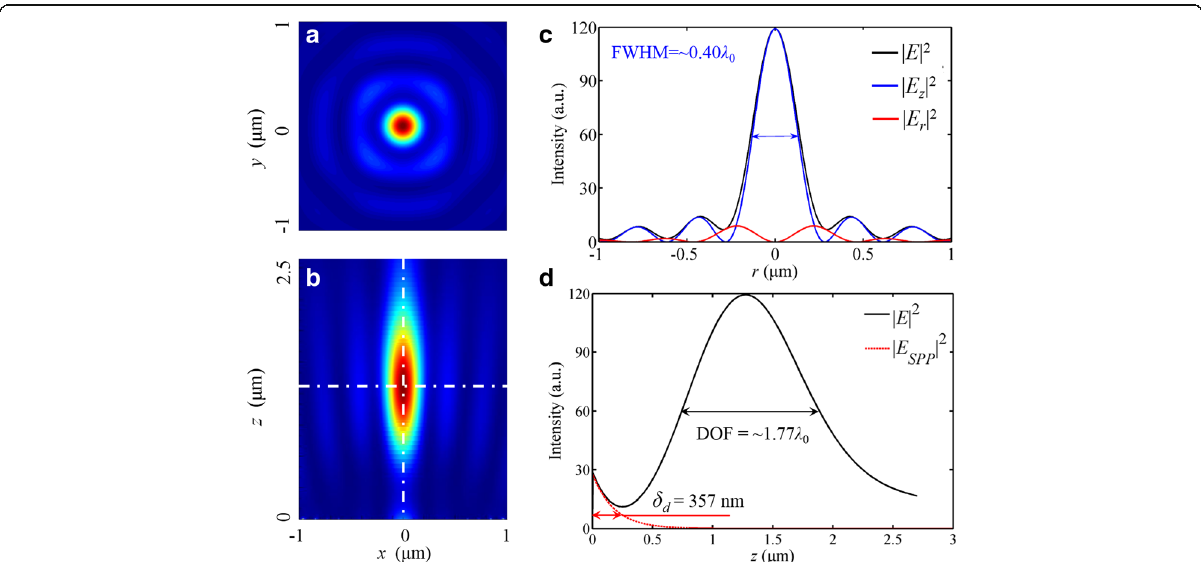
Fig. 8 Intensity distribution of | E | 2 in the case of radially polarized incident light. a , b The distribution in the focal plane and that in x - z cross section. c The intensity profile in the radial direction. d The intensity profile along the optical axis where the black solid line is the total electric field intensity distribution in simulation and the red dashed line is the calculated curve of SPP. The focal length is 1275 nm (a deviation of 1.92%). The FWHM of | E | 2 and | E z | 2 is 272 nm (~0.42 λ 0 ) and 260 nm (~0.40 λ 0 ), respectively. The DOF is ~1.77 λ 0